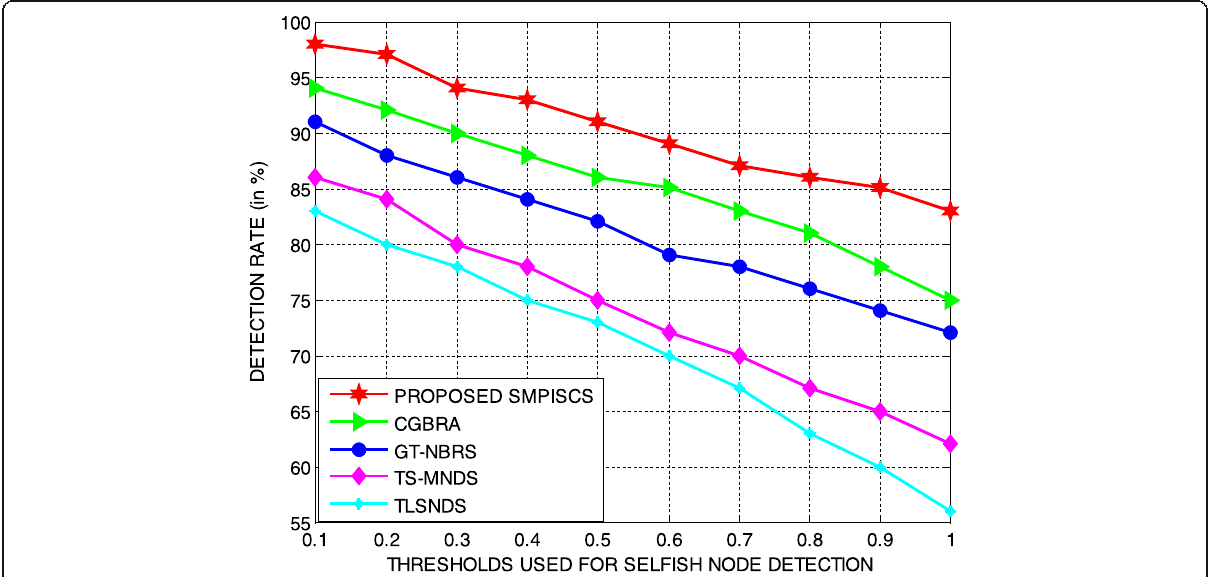
Fig. 14 SMPISCS-Detection Rate (Under different detection